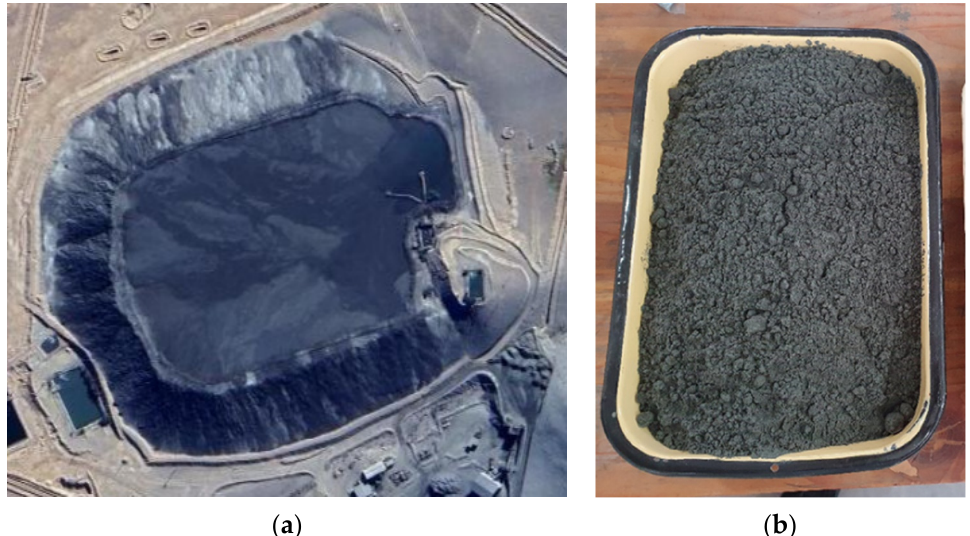
Figure 1. ( a ) Copper tailing dam in Vallenar, Chile [18], and ( b ) the tailing sample obtained.